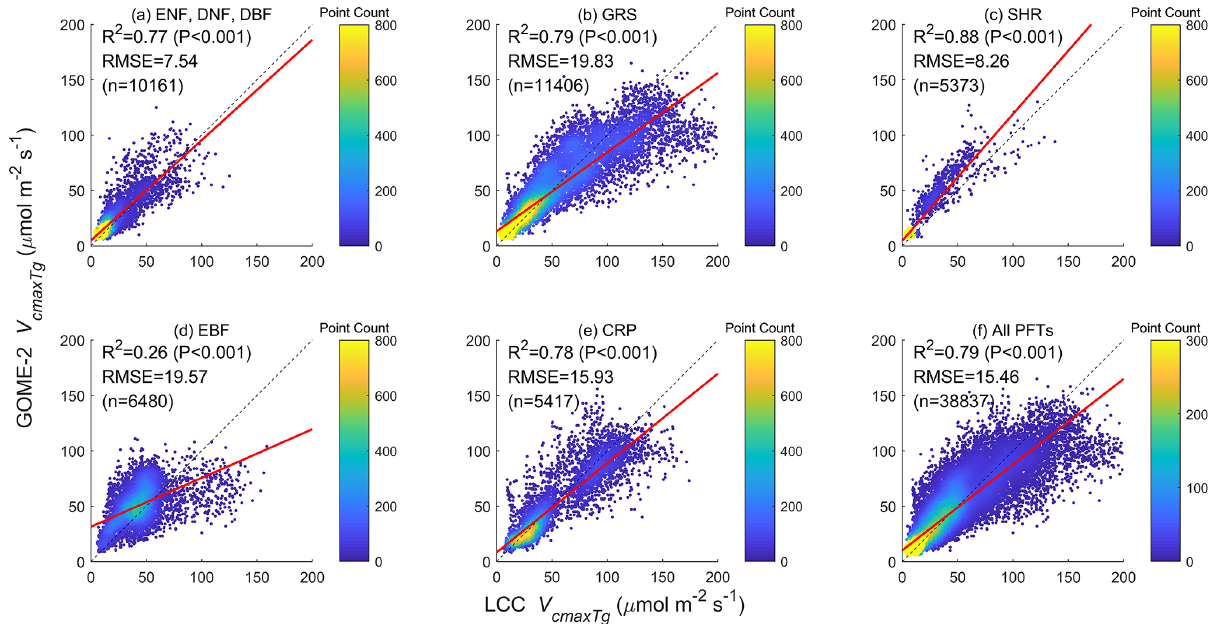
Figure 3. Comparisons of SIF-derived and LCC-derived V cmax values for a group of three PFTs and four individual PFTs, and all PFTs combined. These two sets of V cmax derived independently using two different remote sensing techniques are very well correlated for all PFTs except for the evergreen broadleaf forests (EBFs) in tropical areas where frequent clouds degrade the quality of both SIF and LCC datasets.